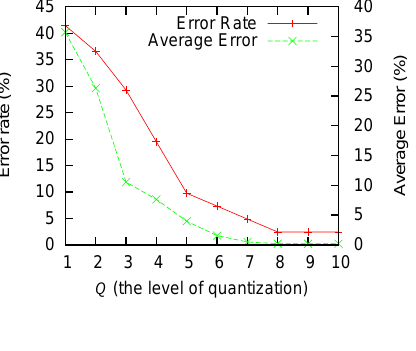
Figure 6. The error rate and average error with different Q